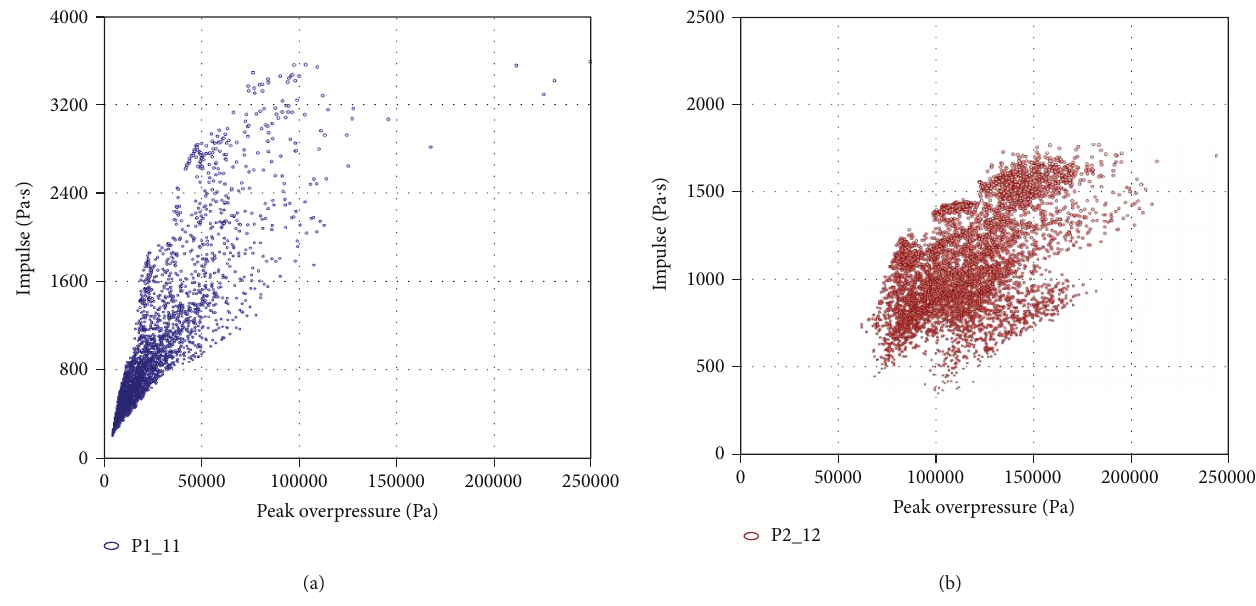
Figure 9: The scatter diagram between peak pressure and impulse. (a) Positive peak pressure and impulse; (b) negative peak pressure and impulse. Table 4: The results for probability distribution of parameters in both pressure